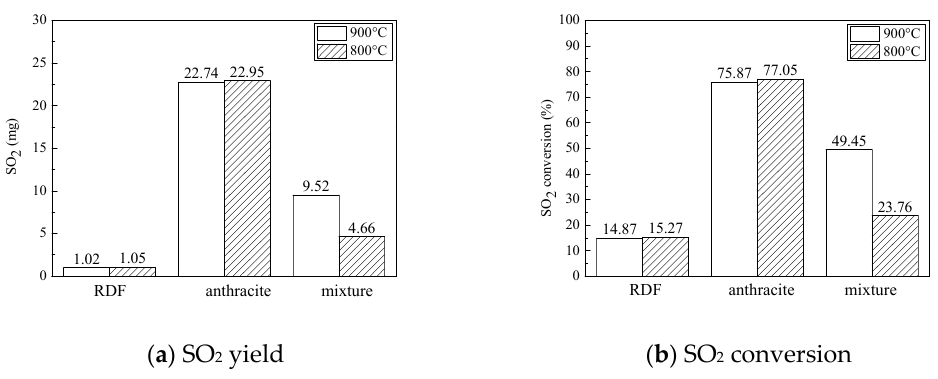
Figure 9. SO 2 emission yield and SO 2 conversion at different temperatures.